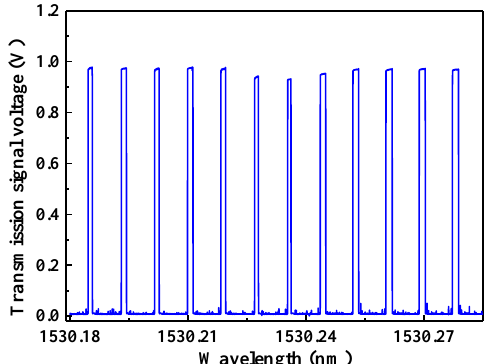
Figure 5. The PDH-locked cavity transmission signal of 1.6% H 2 O at 0.92 atm and 296 K. The target gas is air with a 1.6% H 2 O concentration as determined by the LDAS technique.